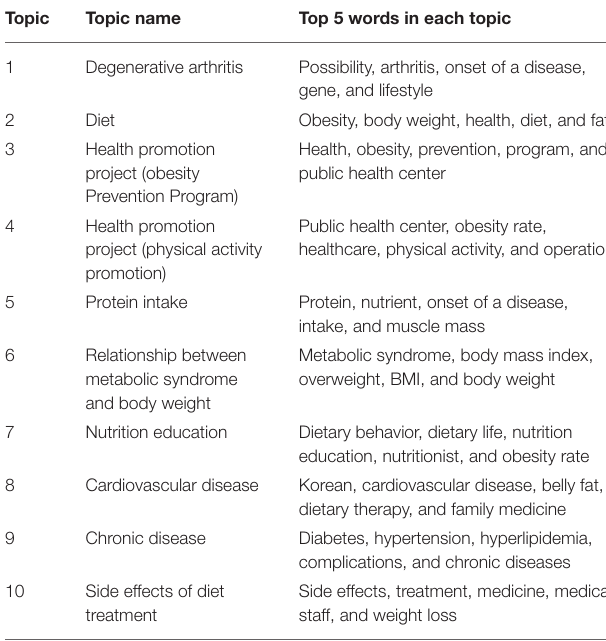
TABLE 6 | Topic modeling before the COVID-19 pandemic.